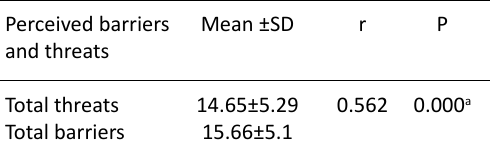
table 6. Correlation between participants' total perceived barriers and threats associated with COVID-19 pandemic Perceived